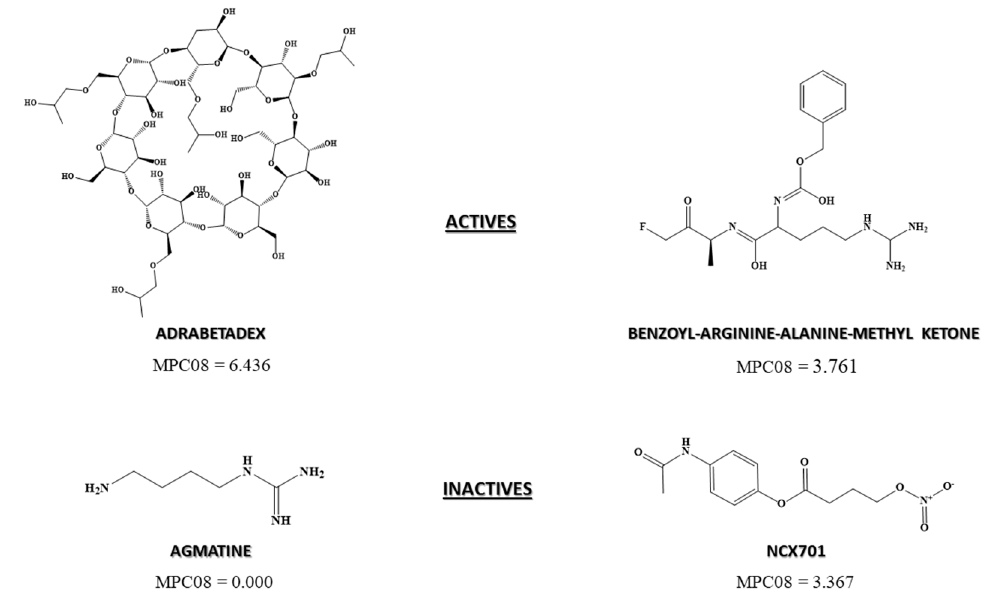
Figure 3. Differences in MPC08 value from active and inactive drugs as